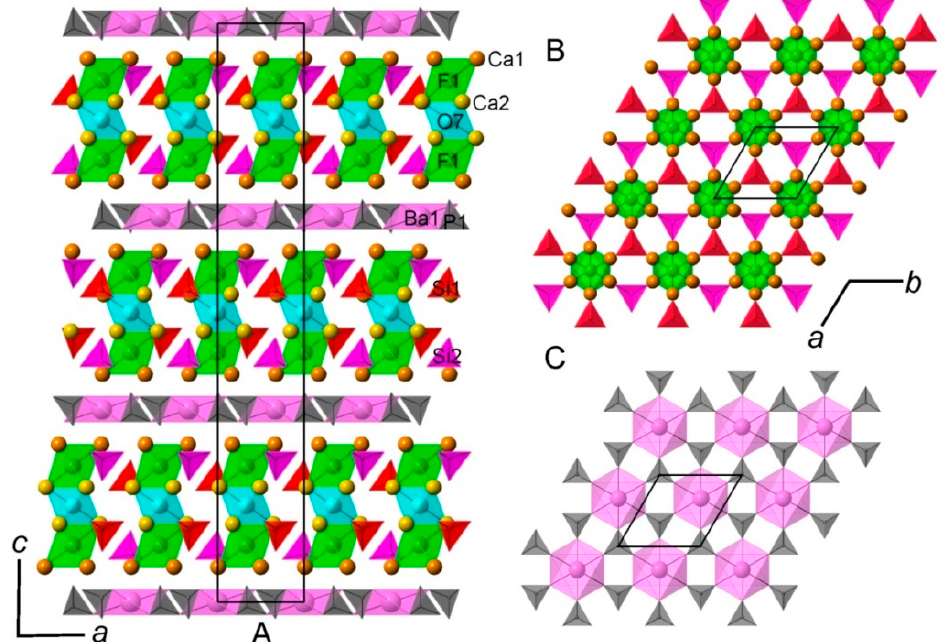
Figure 3. ( A ) The structure of ariegilatite, BaCa 12 (SiO 4 ) 4 (PO 4 ) 2 F 2 O, described as a 1:1 stacking of the two modules {[F 2 OCa 12 ](SiO 4 ) 4 } 4+ and {Ba(PO 4 ) 2 } 4 − along (001). Atoms F1 and O7 are surrounded by six Ca atoms and form face-sharing octahedra (green and blue). ( B ) Module {[F 2 OCa 12 ](SiO 4 ) 4 } 4+ consisting of close-packed seven-fold coordinated Ca (dark yellow filled circles) with (SiO 4 ) filling the gaps (red and purple tetrahedra). ( C) The {Ba(PO 4 ) 2 } 4 − module is characterized by (PO 4 ) tetrahedra (lilac) connected to six-fold coordinated Ba (purple translucent octahedra).